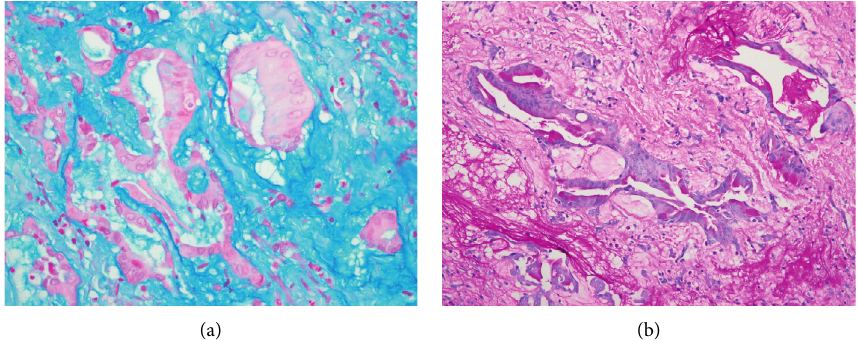
Figure 4: Special stains. Alcian blue (pH: 2.5) (a) and periodic acid–Schiff (PAS) (b) demonstrate mucin production within the glandular component of the tumor and the myxoid background of the tumor (original magnifications × 400 (a) and × 200 (b)).